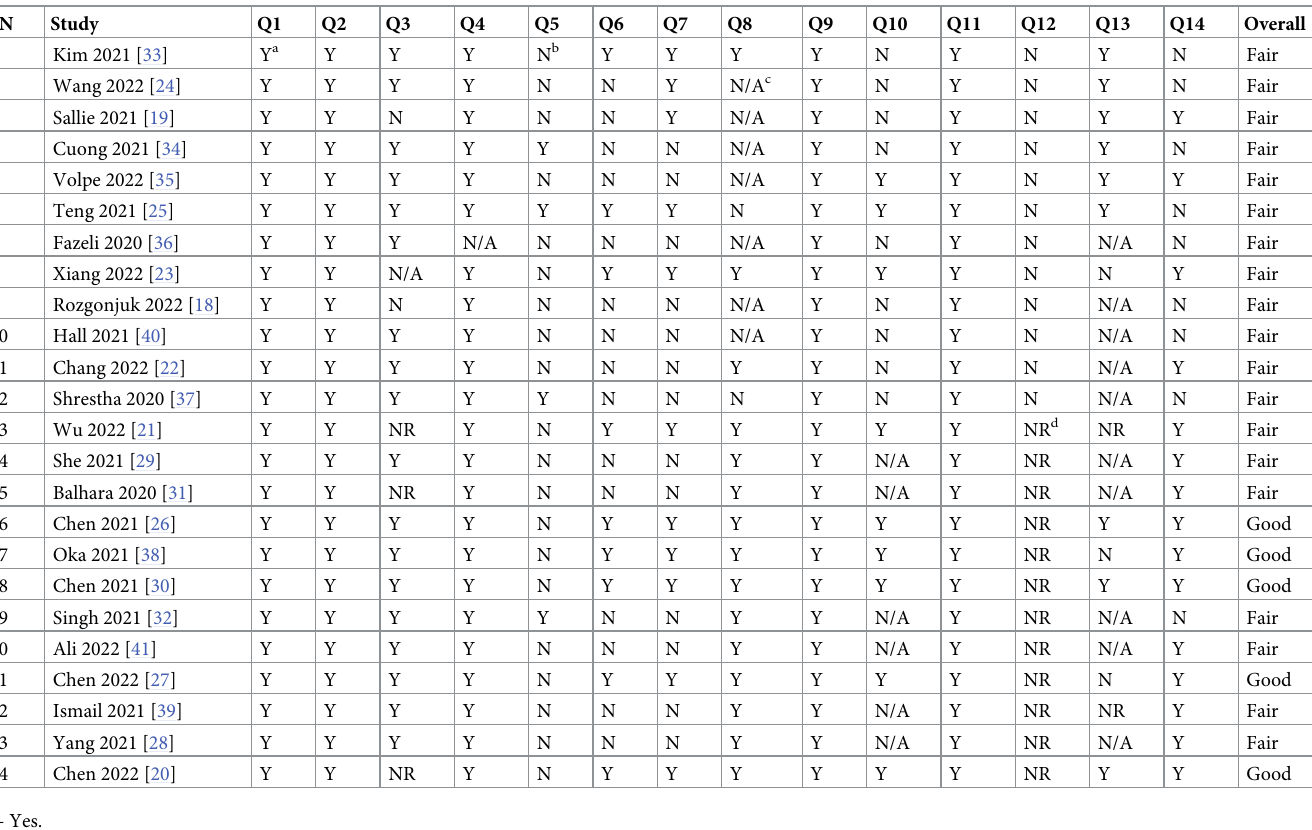
Table 2. Assessment of risk of bias within the